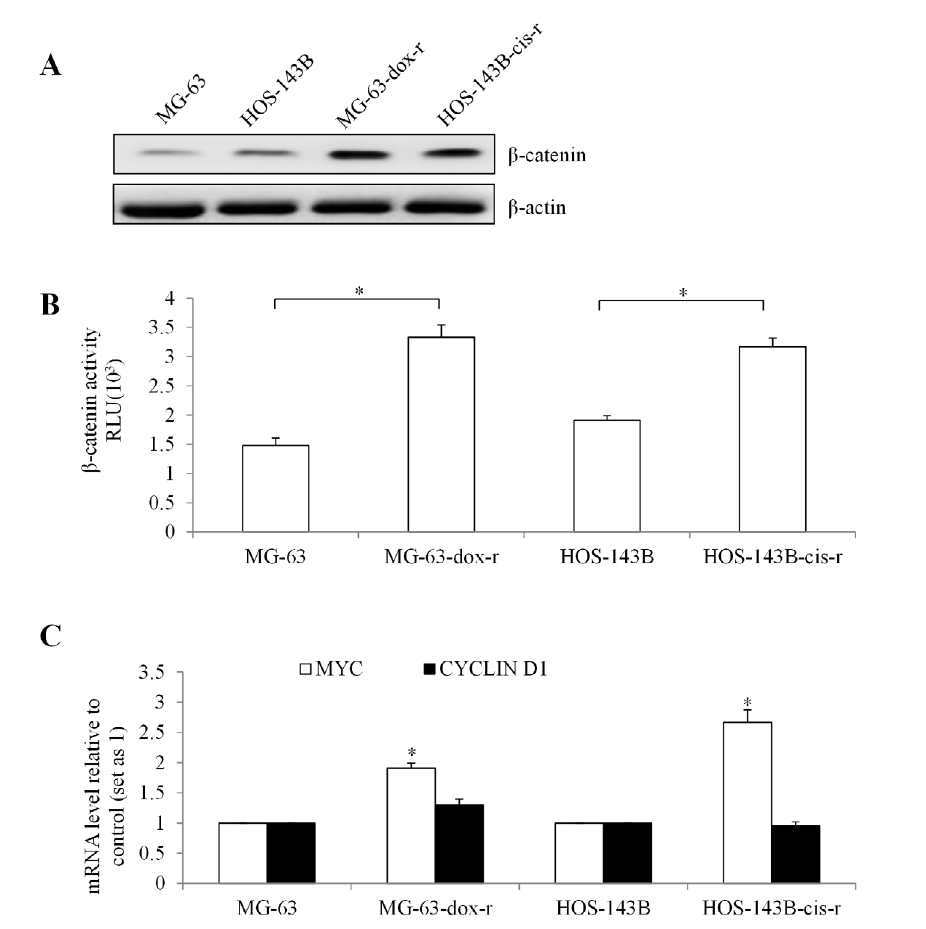
Figure 7 – Chemo-resistant osteosarcoma cells display higher level of β-catenin signaling. (A) Western blot showing on β-catenin level in MG-63, MG-63-dox-r, HOS-143B and HOS-143B-cis-r cells. β-catenin activity (B) and mRNA levels of MYC and CYCLIN D1 (C) in MG-63, MG-63-dox-r, HOS-143B and HOS-143B-cis-r cells. *, p<0.05, compared to MG-63. MG-63 was set up as 1. One-way analysis of variance followed by Tukey’s HSD test and unpaired Student’s test were